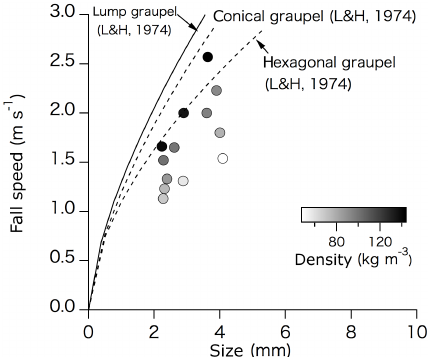
Figure 7. CMF (grey circles) and measured snowfall density of events in the graupel group and small particle group 2. Density is expressed by greyscale shading in the circles. The three curves rep- resent size–fall speed relationships for lump, conical, and hexagonal types graupel (from Locatelli and Hobbs, 1974, denoted as L&H, 1974 on the graph).